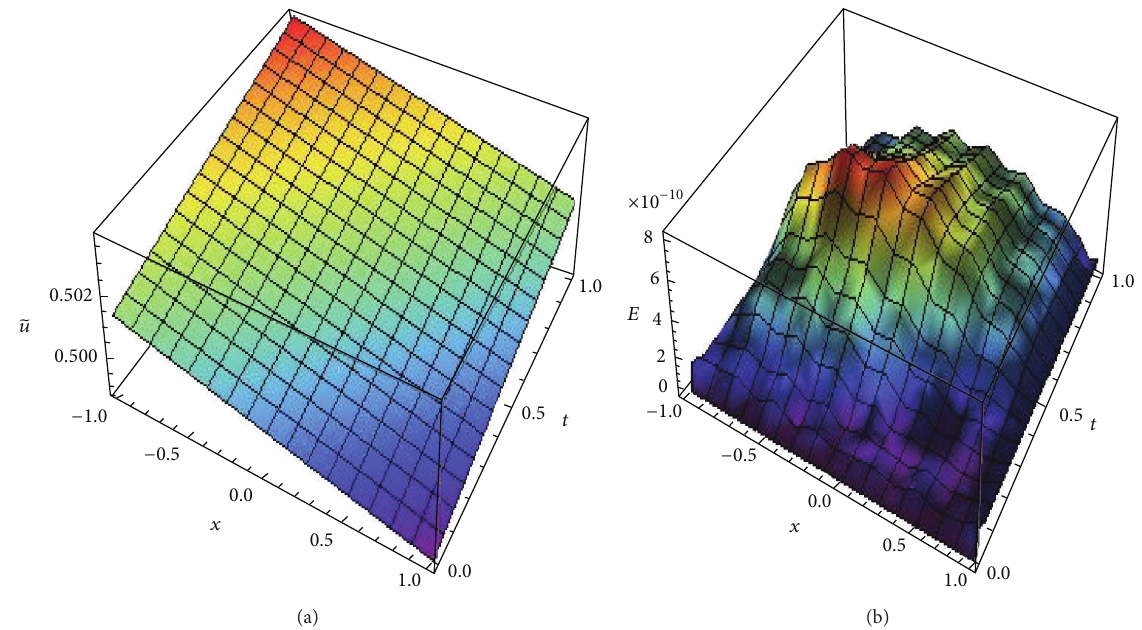
Figure 3: The result of the L-GL-C method at ] = 𝛾 = 10 −2 , 𝛿 = 1 , and 𝑁 = 20 . (a) The approximate solution. (b)The absolute error.